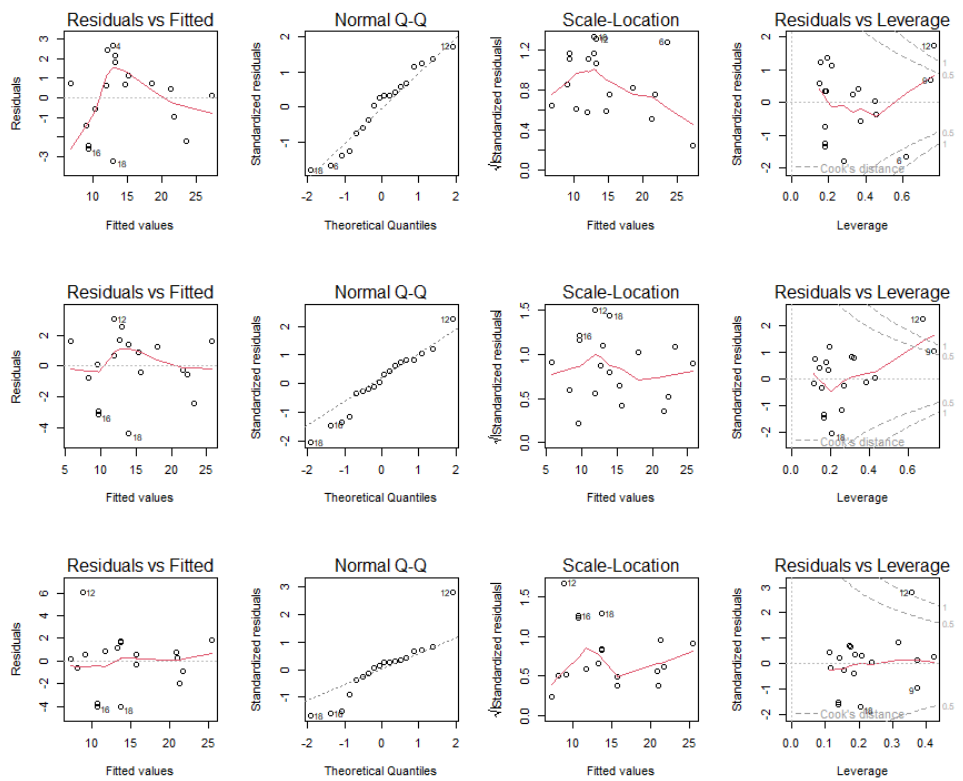
Figure A2. Goodness − of − fit of the shoulder press 1 − RM equation models.